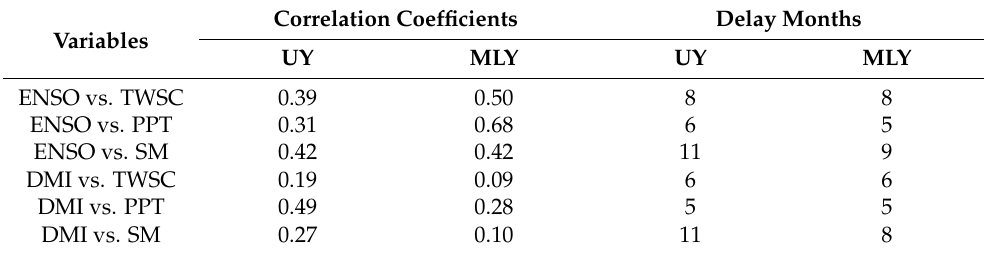
Table 9. The maximum correlation coefficients and the corresponding time delay months between the ENSO index, DMI, and TWSC, PPT anomaly (these results have passed the 95% confidence level). Correlation Coefficients Delay Months Variables UY MLY UY MLY ENSO vs. TWSC 0.39 ENSO vs. PPT ENSO vs.